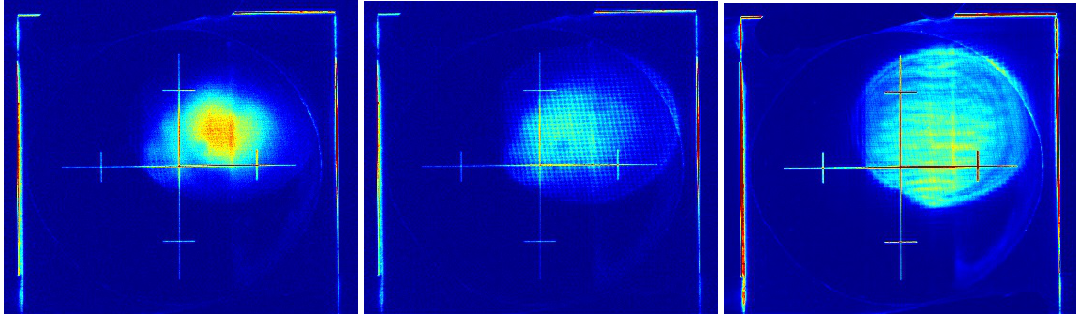
Figure 5. Photon spotsize for 50 ( left ), 85 ( middle ) and 150 nm ( right ) wavelength, 15 m downstream of the undulator with automatic optics adjustment in the undulator switched on. Without adjustment, the undulators cannot be closed to produce wavelengths longer than 85 nm because of beam